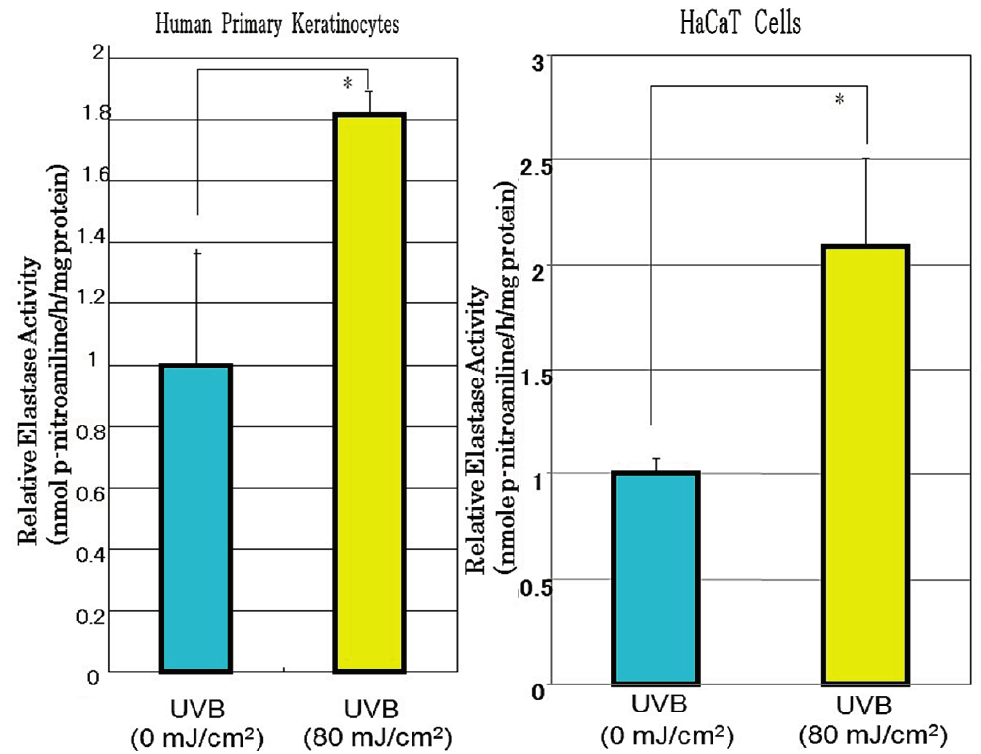
Figure 5. Effects of conditioned medium from UVB-exposed human primary keratinocytes or HaCaT cells on neprilysin activity in human fibroblasts. Neprilysin activity levels were measured by enzymatic assay using N -succinyl- tri -alanyl- p -nitroaniline (STANA) 72 h after the addition of the conditioned medium at a 1:1 dilution to human fibroblasts. The release of p-nitroaniline was measured by absorbance at 405 nm and enzymatic activity was expressed as nmol STANA/h per μ g of protein to calculate as relative elastase activity. Values are means ± S.D. derived from three independent experiments. * p <